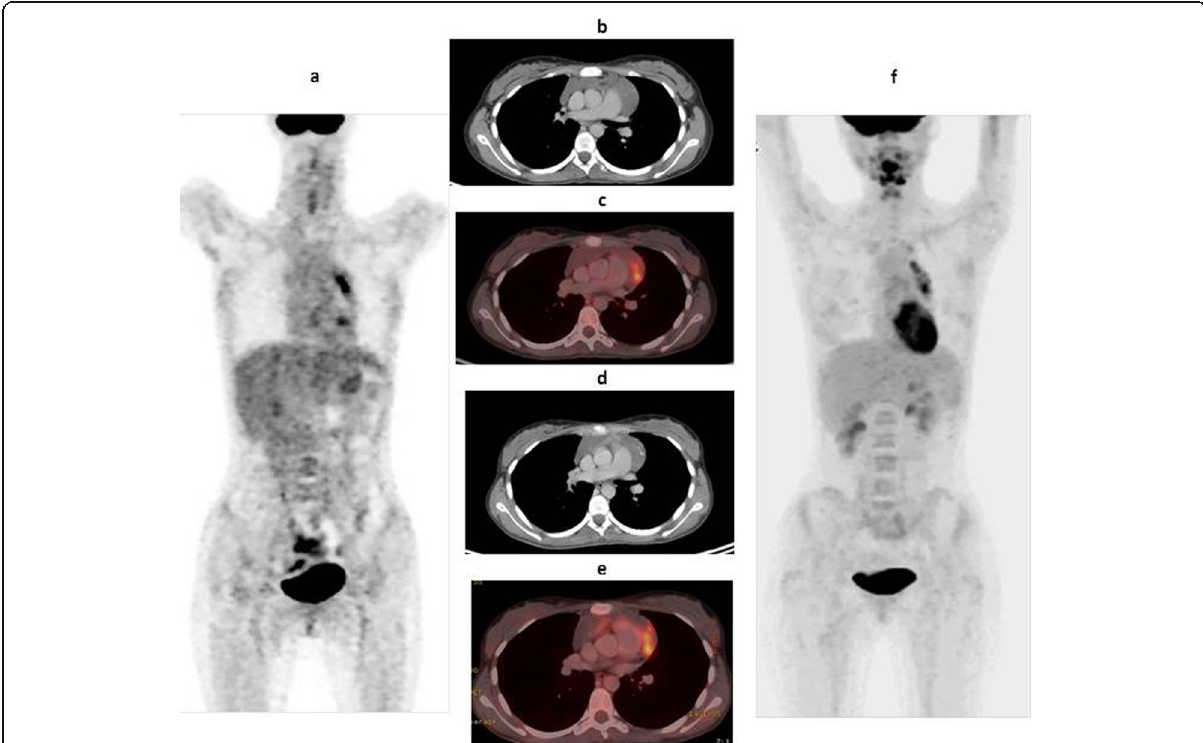
Fig. 4 A 20-year-old female patient, recently diagnosed case of HL. Initial PET/CT study revealed hypermetabolic mediastinal mass in whole body PET MIP image ( a ), formed of enlarged amalgamated retrosternal/prevascular mediastinal in axial CECT image ( b ) and achieving 5.5 SUL peak in corresponding fused PET/CT image ( c ). Follow-up PET/CT study still showed the hypermetabolic mediastinal mass in whole body PET MIP image ( f ) that was of stationary size in axial CECT image ( d ) denoting SD according to RECIST 1.1, and almost showing stationary FDG uptake (6 SUL peak ) in fused PET/CT image ( e ) denoting SMR according to PERCIST